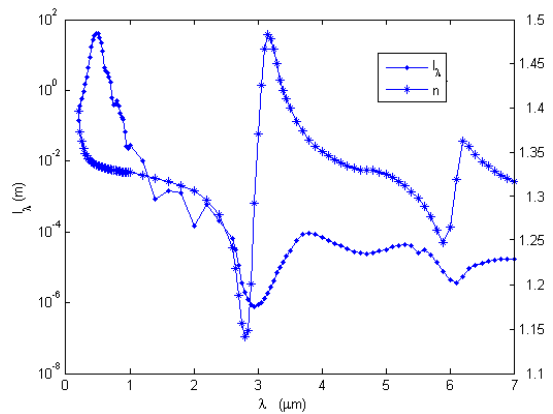
Figure 2. Index of refraction and penetration depth of